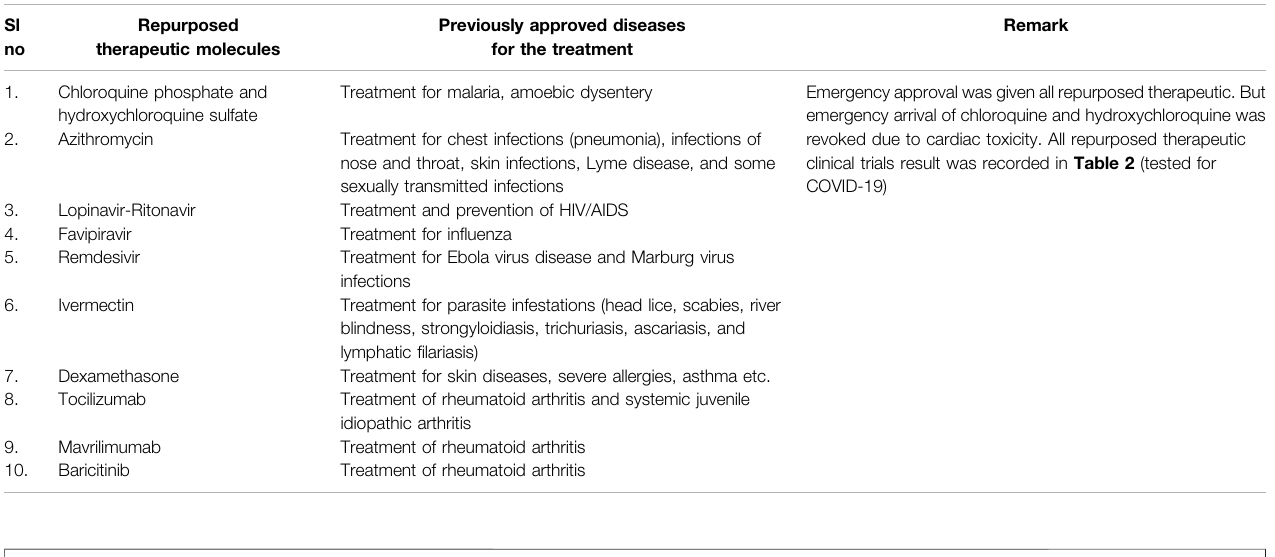
TABLE 1 | List of different repurposed therapeutic molecules for COVID-19.